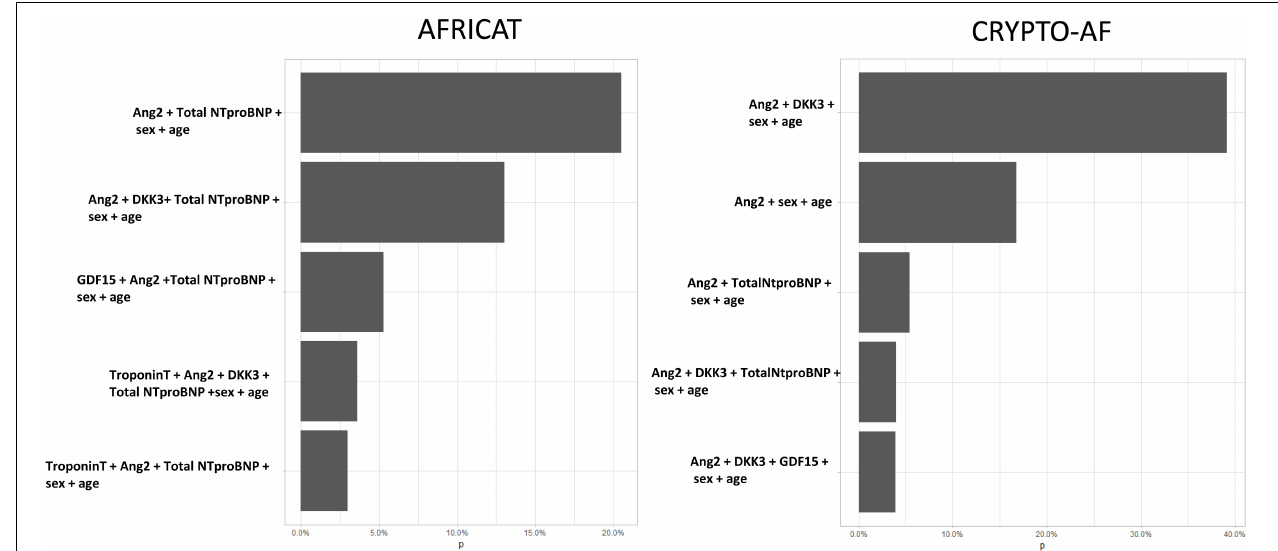
FIGURE 4 | Five most frequent biomarker combinations after 1,000 stepwise logistic regression boostrap iterations. X axis represents de percentage of boostrap iterations in which the combination was selected. In total, 150 combinations were selected in the AFRICAT cohort, and 72 in the CRYPTO-AF cohort.